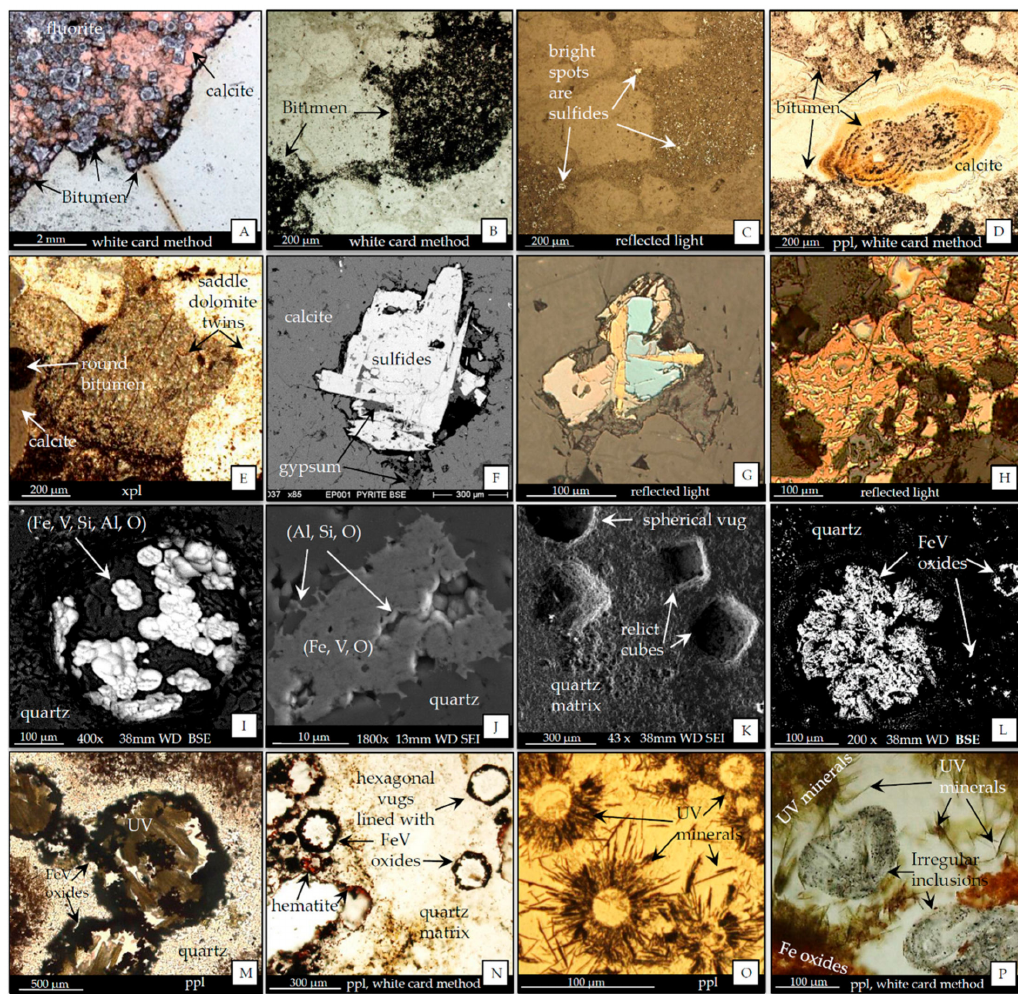
Figure 7. Images of bitumen and vugs: ( A ) bitumen lining clast of silicified limestone. Red stained calcite fills in porosity of oolites metasomatically replaced by fluorite, Dandy mine, PMD, ppl, white card method; ( B ) Bitumen filled in porosity of E. Pryor mine breccia, ppl, white card method; ( C ) Sulfides appear bright in reflected light view of B; ( D ) Calcite filling in fracture with bitumen inclusion “bleeding” out in concentric rings, Dandy mine, PMD, ppl, white card method; ( E ) Round bitumen is preserved in late-stage calcite of breccia and saddle dolomite twins show up in xpl, E. Pryor Mountain Group, PMD; ( F ) Sulfides and gypsum formed in round vug, E. Pryor mine, PMD, BSE; ( G ) Isotropic Fe-sulfides in reflected light; four different isotropic minerals are shown in this view, blue may be Ni-bearing pyrite and pinkish brown may be bornite Cu 5 FeS 4 , E. Pryor mine, ppl; ( H ) Two isotropic Fe-sulfides in reflected light exhibiting myrmekite texture, pyrite may be the yellow mineral, E. Pryor mine, ppl; ( I ) Fe-V oxides with clay mineral coating, BSE, 400 × magnification; ( J ) Another portion of sample in 7I shows Fe-V oxides with clay mineral coating, SEI, 1800 × magnification; ( K ) Spherical and cubic shaped vugs in quartz matrix, Old Glory mine, SEI, 43 × magnification; ( L ) BSE of K, microscopic Fe-V oxides visible in large vug, lining smaller vug and between microcrystalline quartz crystals, 200 × magnification; ( M ) Tyuyamunite or metatyuyamunite crystals in Fe-V oxide lined, bleached circular vugs ( N ) Clear quartz matrix with hexagonal Fe-V oxide rimmed vugs and red hematite along edge, Old Glory mine, PMD, ppl, white card method; ( O ) Tyuyamunite or metatyuyamunite crystals radiating out from circular vugs in calcite fracture appear dark due to Ir coating on slide used for SEM work, LMD, ppl; ( P ) U-V minerals radiating from a fracture lined with Fe oxides, with irregular inclusions in a limestone breccia, LMD, ppl, white card method. Figure modified from Moore-Nall and Lageson